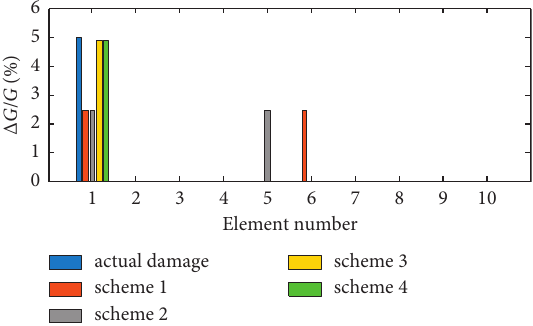
Figure 6: Detection of Case 1 using Schemes 1–4.